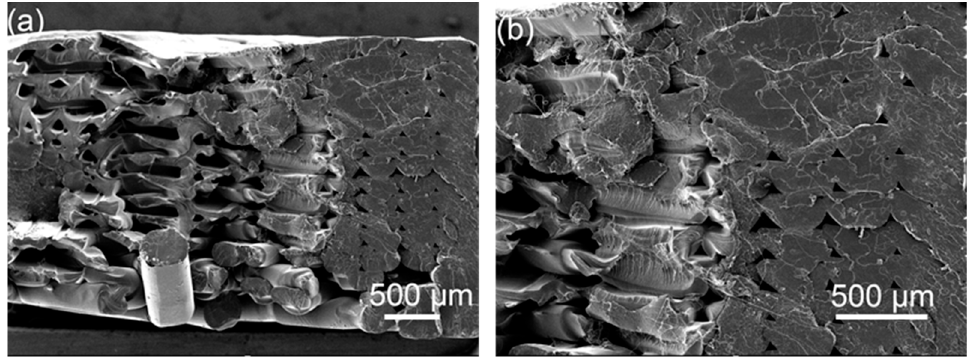
Figure 16. Electron micrograph of the tensile cross ‐ section of the static load compression sample ( a ) 30 times ( b ) 50 times. ( a ) 30 times ( b ) 50